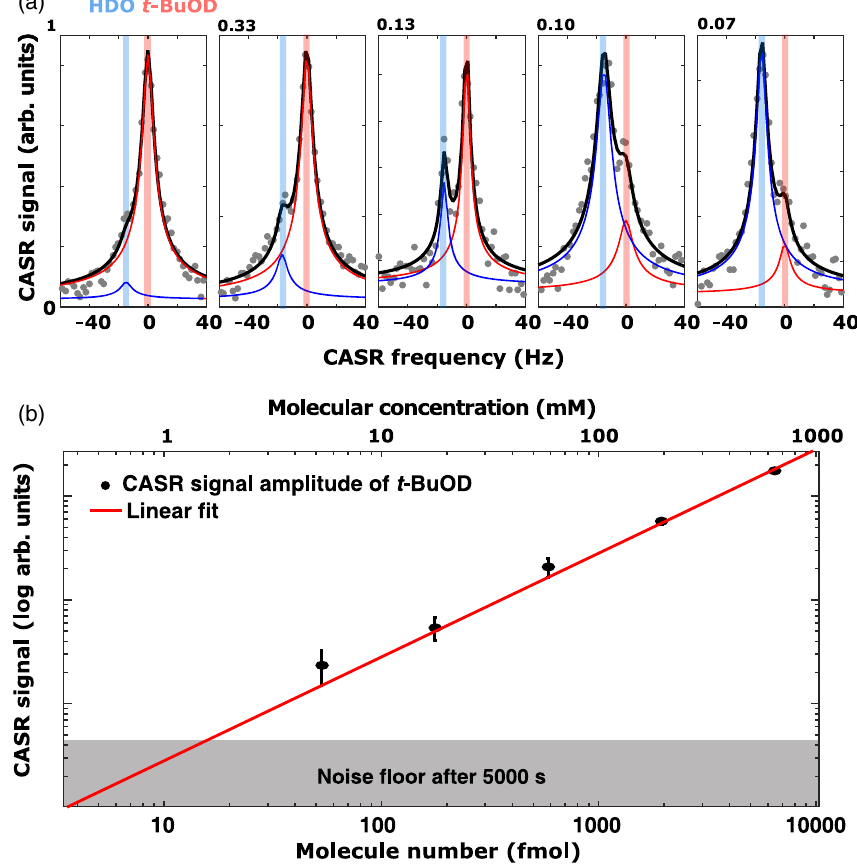
FIG. 3. Sensitivity of hyperpolarization-enhanced NV NMR. (a) CASR-detected spectra of DNP-enhanced t -BuOD solutions at different millimolar concentrations (650 mM, 195 mM, 58.5 mM, 17.6 mM, 5.3 mM, from left to right) in D 2 O. Spectra are fit to represent the t -BuOD sample (red solid line) and residual semiheavy water (HDO) in the D 2 O (blue solid line), with red and blue vertical lines indicating the NMR resonance frequencies of t -BuOD and HDO, respectively. (b) Plot of CASR signal fit amplitude of t -BuOD against number of sample molecules in the sensing volume (bottom axis) and sample molecular concentration (top axis). Gray area at the bottom marks the noise floor after 5000 s of averaging with a signal to noise ratio (SNR) ≈ 3 . 5 for a concentration of 5.3 mM, equivalent to ∼ 50 fmol of sample molecules in the 10 pL detection volume. Error bars represent standard deviation ( 1 σ ) of CASR signal measured across three independent experiments.